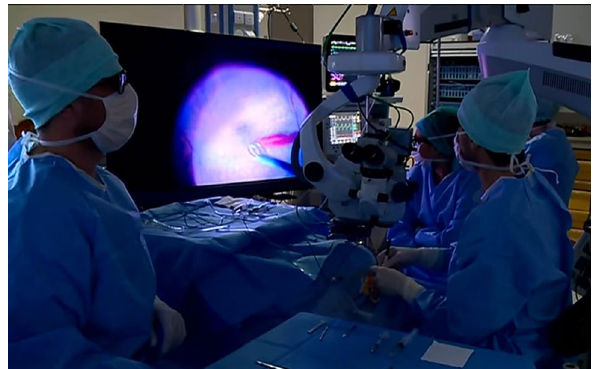
Figure 1. Our operating room configuration with the heads-up NGENUITY 3D Visualization System. The microscope eyepieces were left in place for the conventional microscopy (CM) group and replaced by the